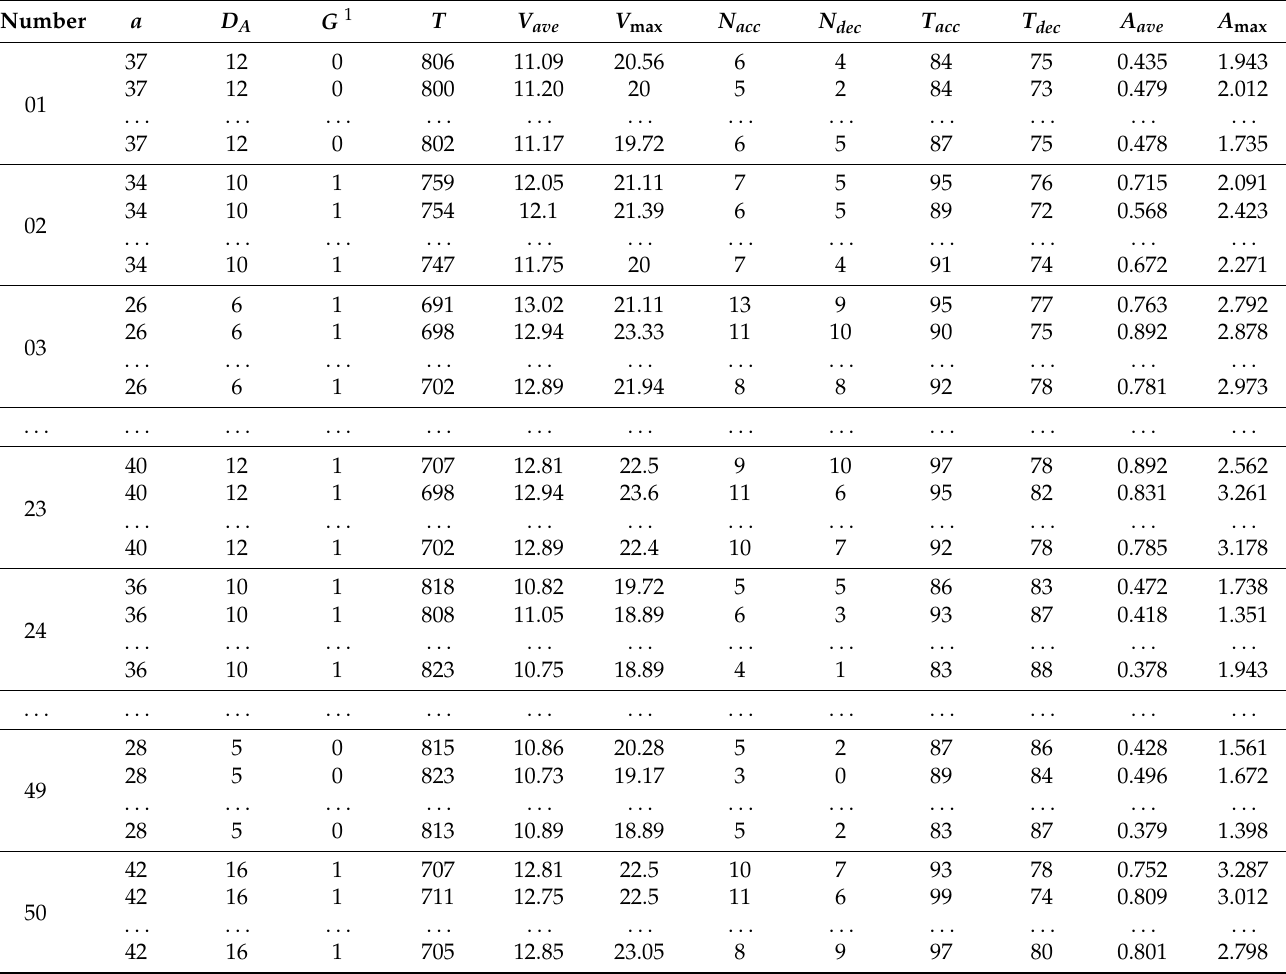
Table 6. Partial experimental